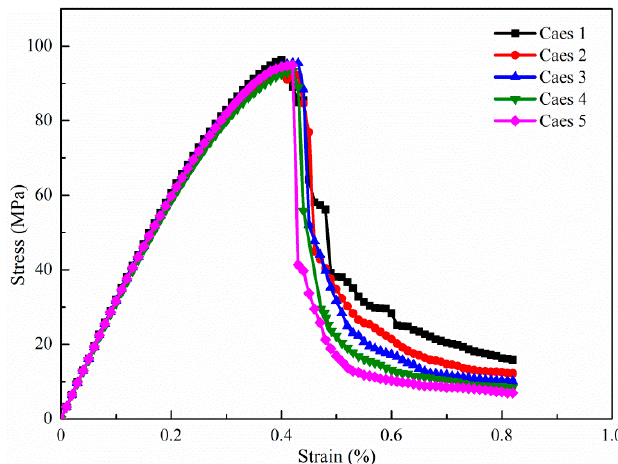
Figure 23. Stress–strain curves of five numerical cases of different gravel size gradations. Table 7. Strength parameters and brittleness indexes of five cases of different size gradations.